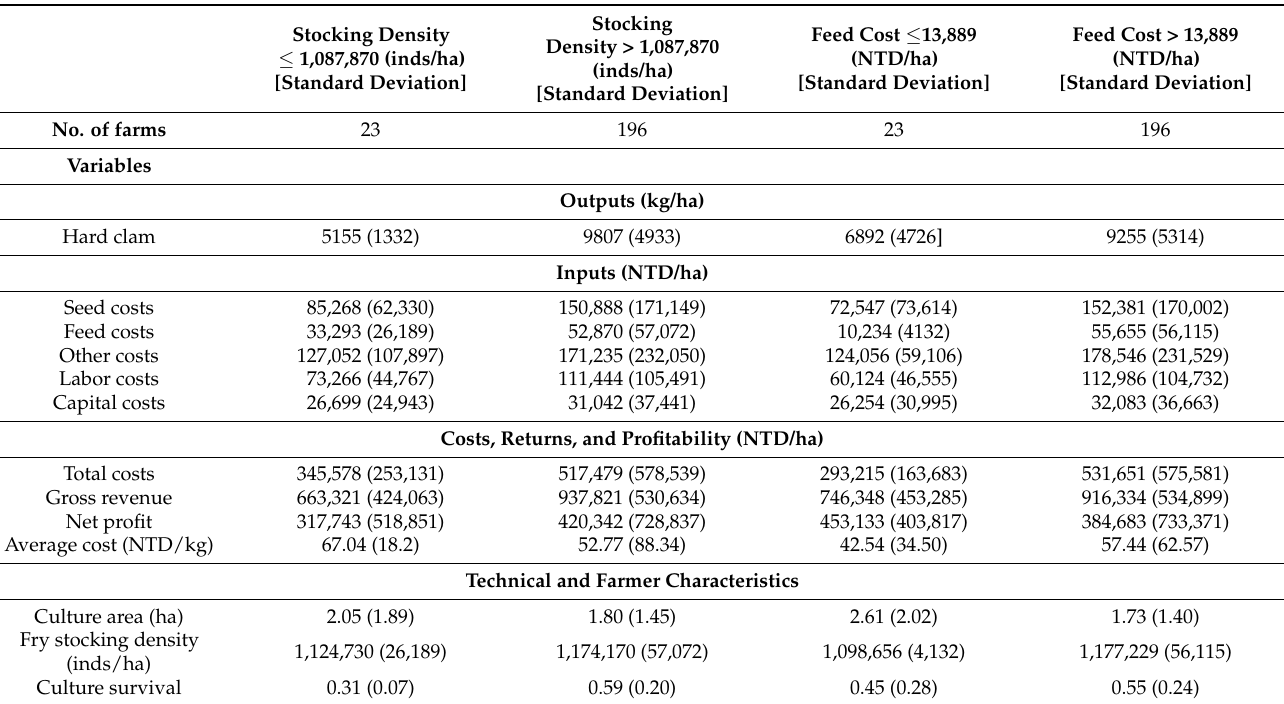
Table 4. Summary of hard clam culture farming profits and cost structure in the two fry stocking density and feed input groups in Yunlin county,